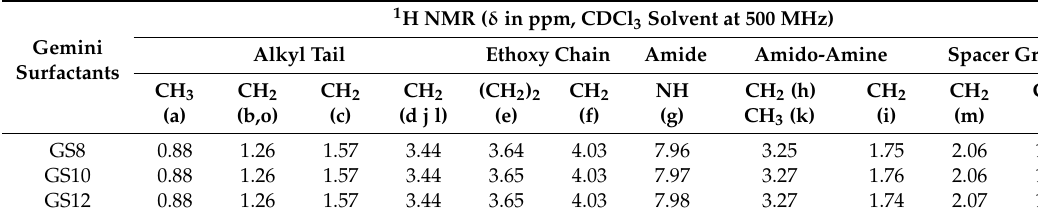
Figure 1. 1 H NMR of intermediate 4.